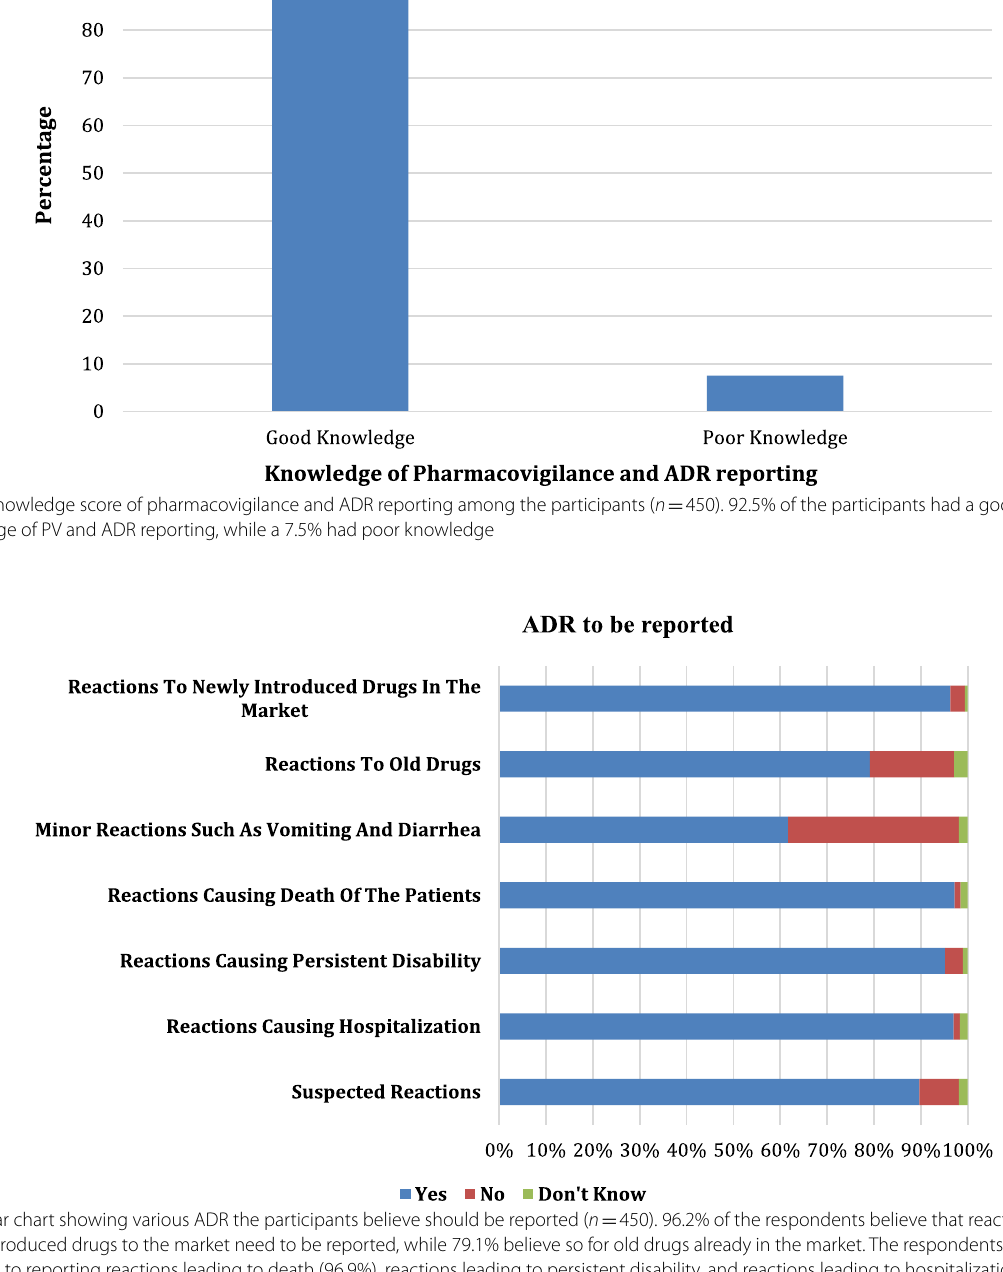
Fig. 2 Bar chart showing various ADR the participants believe should be reported ( n 450). 96.2% of the respondents believe that reactions to = newly introduced drugs to the market need to be reported, while 79.1% believe so for old drugs already in the market. The respondents were favorable to reporting reactions leading to death (96.9%), reactions leading to persistent disability, and reactions leading to hospitalization (97.5%). Just 61.7% believe that minor reactions such as vomiting and diarrhea should be